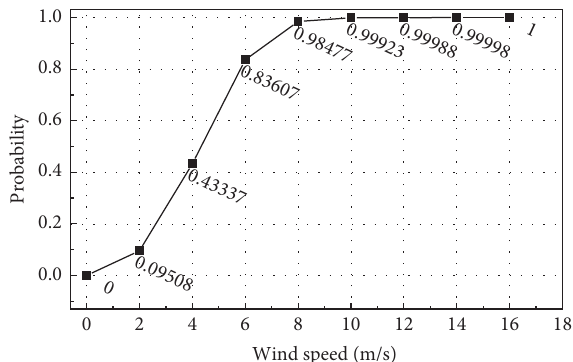
Figure 17: Wind speed cumulative distribution function in West Africa